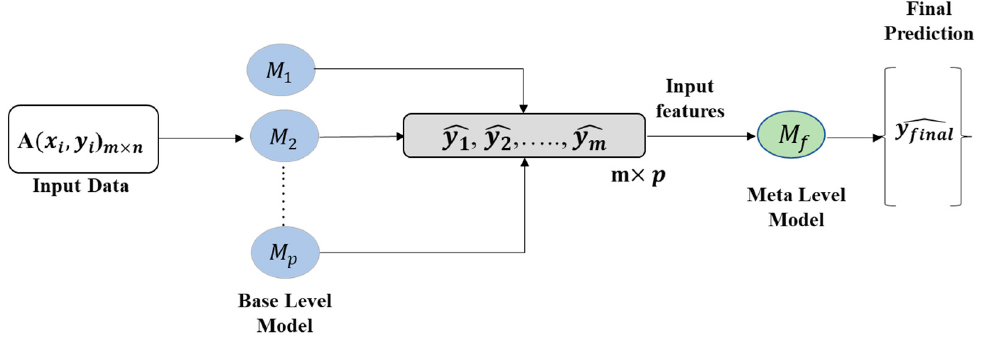
Figure 1. The general architecture of the stacked approach.